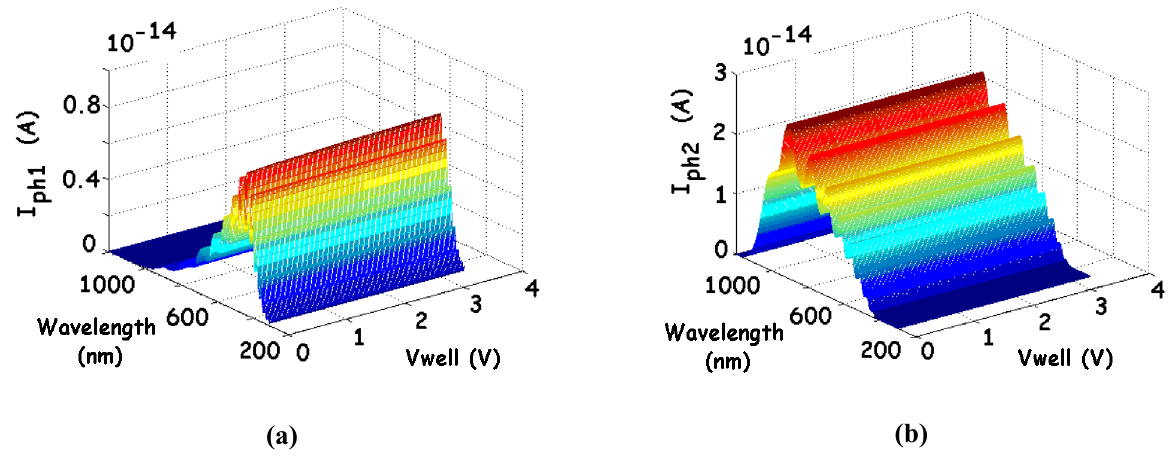
Figure 7. Matlab computed photocurrents of the BDJ detector versus the wavelength and the reverse bias, considering the reflection coefficient R in SiO and (b) Photocurrent of the deeper junction J shallow junction J 1